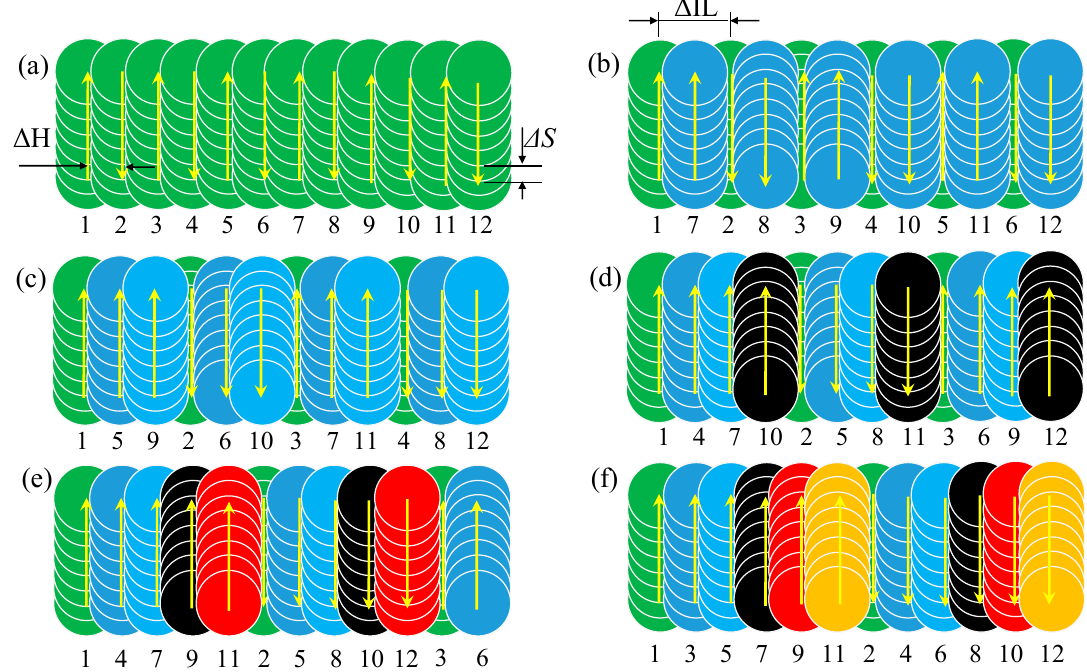
Figure 4. Schematic representation of ( a ) bidirectional sequential method (SM) and ( b – f ) bidirectional interlacing method (IM). ( b ) IM with one line skip ( ∆ IL = 2 ∆ H ), ( c ) IM with 2 line skips ( ∆ IL = 3 ∆ H ), ( d ) IM with 3 line skips ( ∆ IL = 4 ∆ H ), ( e ) IM with 4 line skips ( ∆ IL = 4 ∆ H ), and ( f ) IM with 5 line skips ( ∆ IL = 5 ∆ H ). In all these scanning modes, the total process time is identical. For image clarity, the hatch distance was chosen at half the laser spot diameter in this illustration.